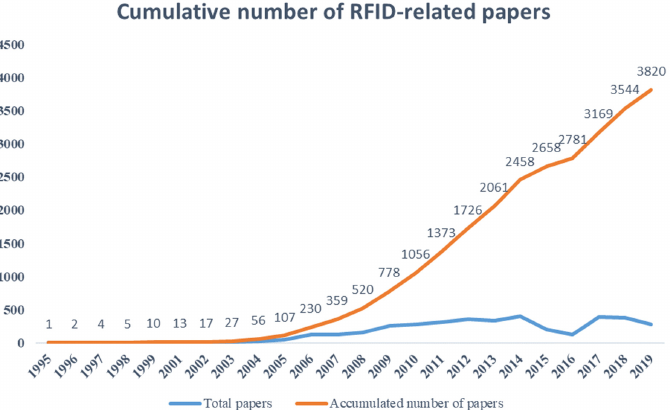
Figure 4. Cumulative number of RFID-related